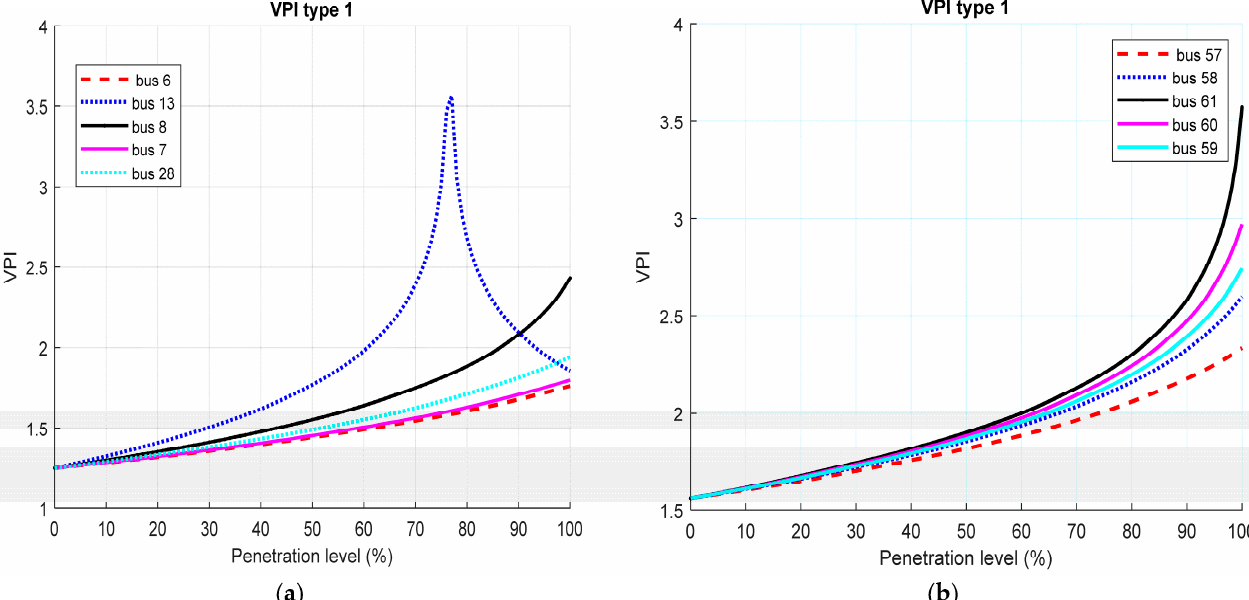
Figure 15. VPI when Type 1 DG was connected to selected buses of IEEE ( a ) 33-bus ( b ) 69-bus RDNs.